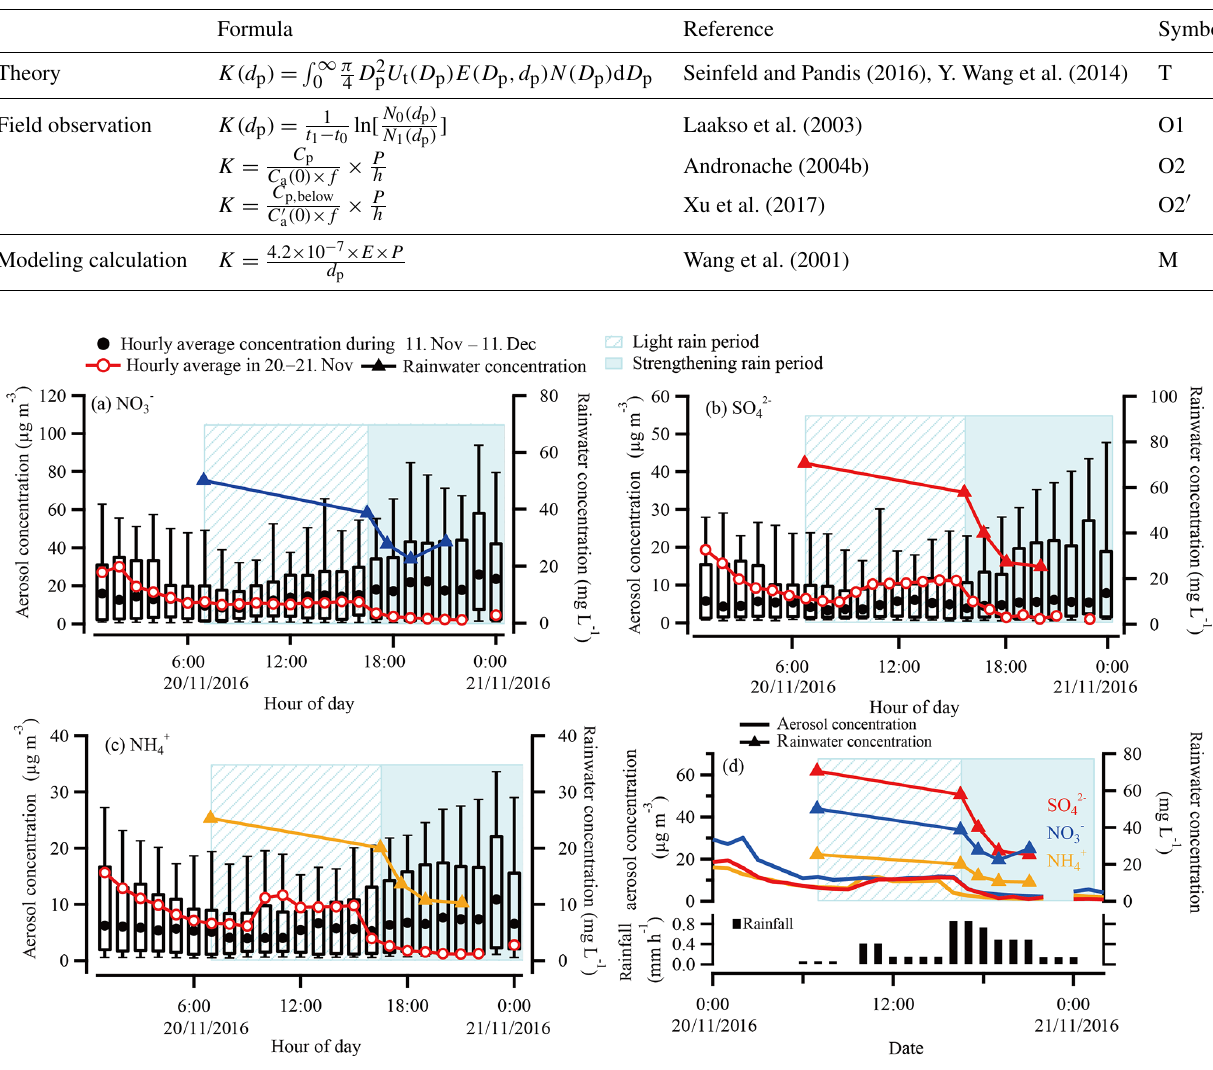
Table 1. List of multi-method calculations for the BWSCs.